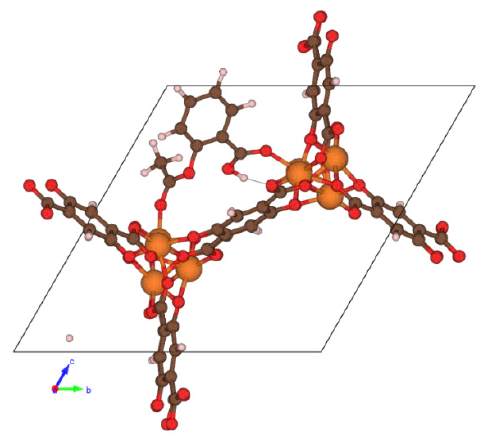
Figure 1. Projection of the CPO-27-Mg cell with aspirin, no solvent is shown. The only coordination bond of paracetamol with the surface of CPO-27-Mg occurs due to the presence of the carbonyl group in the molecule (Figure 2); the hydroxyl group is bound by water molecules. Based on general ideas, one can guess that the desorption of the triple bound aspirin should be more complicated and therefore less energetically beneficial than the desorption of single bound paracetamol. Figure 2. Projection of the CPO-27-Mg cell with paracetamol, no solvent is shown. However, in our case of desorption to water, computational results (Table 2) gave − 5.6 kJ mol − 1 of E des (water) for aspirin and 51.8 kJ mol − 1 for paracetamol. The discrepancy of the guess and our results can be explained by strong solvation effects which were evaluated as E des (water) − E des (g) giving − 238.1 kJ mol − 1 for aspirin and − 118.7 kJ mol − 1 for paracetamol. Although the contribution of dispersion forces to E des (water) is significant, 42.4 and 60.0 kJ mol − 1 for aspirin and paracetamol, respectively, most of the binding energy comes from covalent interactions. These values are in agreement with those reported previously by Horcajada et al. for the case of drug-containing complexes of MIL- 53(Fe) where only dispersion interactions occurred [4–6]. Thus, the desorption of these molecules to a gas phase is almost impossible, they can be released from the MOF pores to water, wherein Asp@CPO-27-Mg flawlessly suits the criterion on E des , and despite the higher value of E des (water) Par@CPO-27-Mg still can be used as a drug delivery complex.